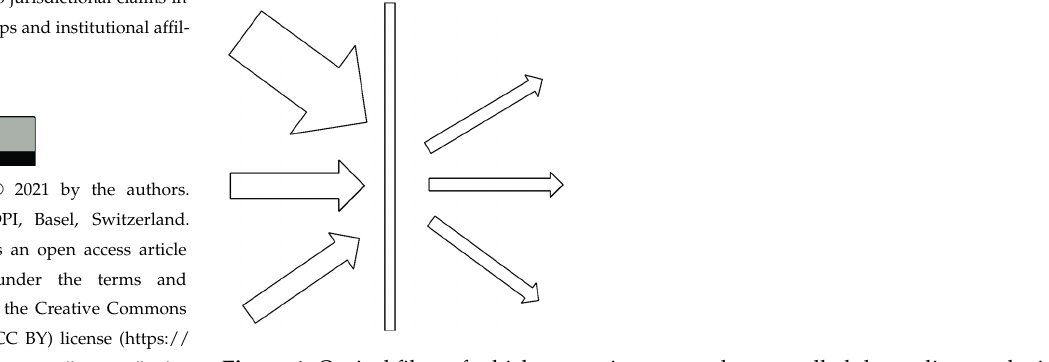
( a ) ( b ) Figure 2. ( a ) Structure of HAN GH-LCDs; ( b ) Structure of high pretilt angle GH-LCDs. As shown in Figure 2a, the two substrates of HAN GH-LCDs possess two types of alignment layers, namely a homogeneous and a homeotropic layer. The polar angle of LC molecules varies from 2 or 3 degrees (the pretilt angle of the homogeneous alignment layer) to 90° continuously from the surface of the homogeneous alignment layer to that of the homeotropic alignment layer. Therefore, the molecules at the center of the LC layer are inclined at approximately 45° from the substrate surface plane. It was proposed that by using an inclined molecular arrangement, the incident angle dependence of the transmittance can be controlled. The reverse polymer-dispersed LC (PD-LC) mode with a HAN structure, which causes light scattering when an electric field is applied, shows the incident angle dependence of the transmittance [1–3]. This applica- tion has been proposed for smart windows as well as displays and other applications [4– 7]. In these papers, except for the usage of the light scattering phenomenon [1–3], polar- ized light was used. This is because HAN-LCDs work only for the polarized light vibrat- ing parallel to the LC direction. This study proposes a method for HAN-LCDs to work for non-polarized light. Figure 2b shows the alignment layers of high pretilt angles. Alignment layers with a high pretilt angle can be realized by a mixture of the polyimide material for homogeneous alignment layers and one for homeotropic alignment layers [8]. In Figure 3, the light passes through the single HAN-LCD from the incident angles Θ and– θ , where Θ is the polar angle in the middle of the LCD. The p-wave of the incident light, from the direction Θ , vibrates parallel to the long axis of the dichroic dye and is absorbed effectively.